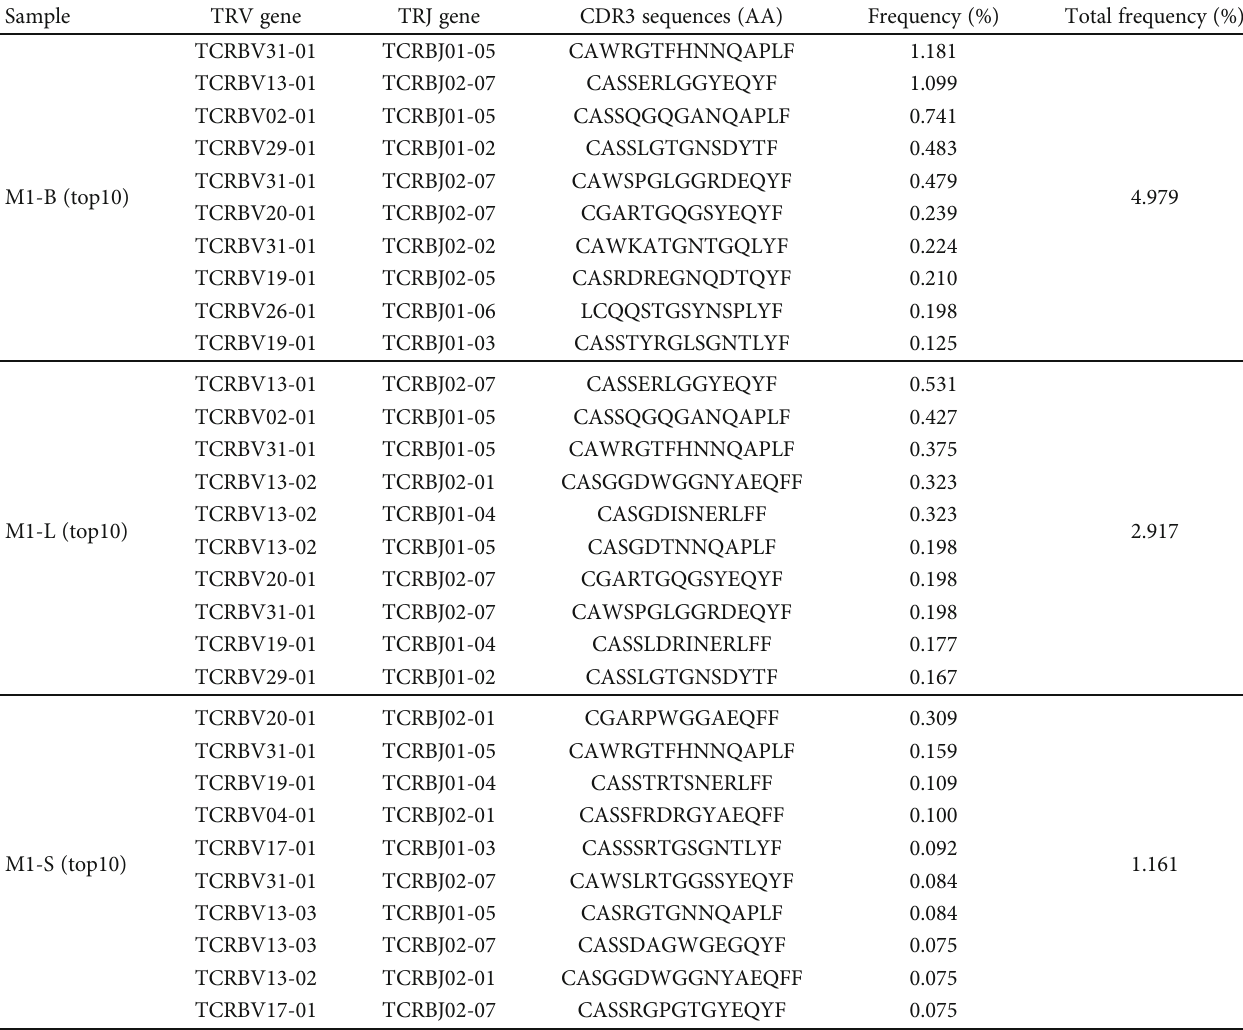
Table 5: Analysis of composition and characteristics of frequency for the top ten sequences and the usage of TRBV and TRBJ gene, CDR3 AA of CD4 + CD25 + T cells TCR β CDR3 repertoires in breast tumor tissues, lung metastatic tissues, and spleens from 4T1 tumor-bearing BALB/c mouse